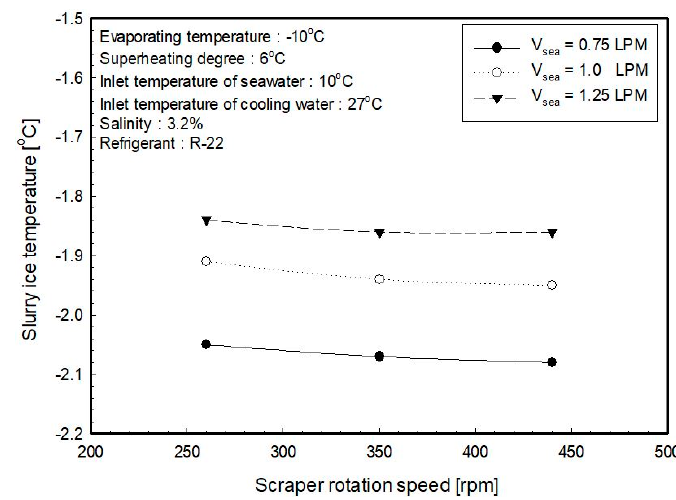
Appl. Sci. 2018 , 8 , x FOR PEER REVIEW Figure 11. Temperature of ice slurry with seawater according to scraper rotation speed.